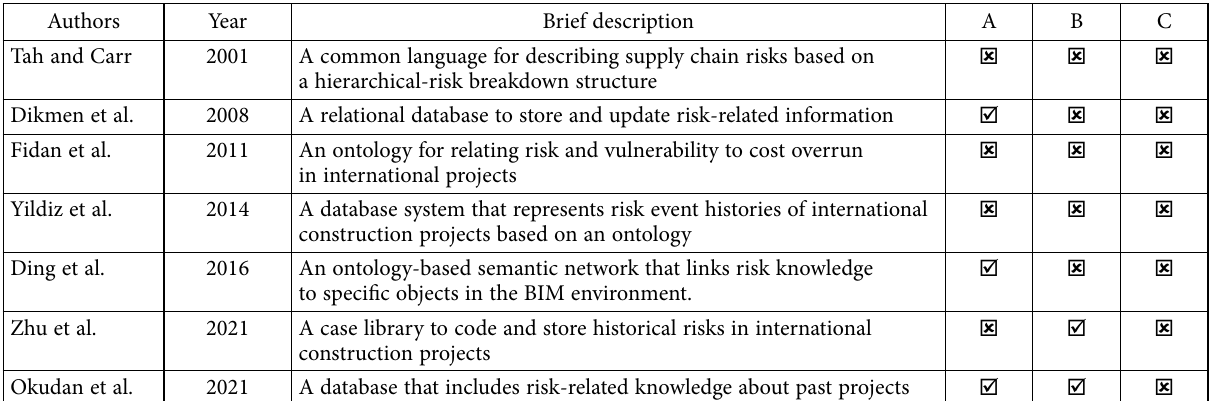
Table 1. A review of the existing organizational risk